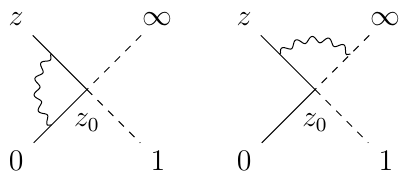
Figure 3 . Contributions to the four point blocks from the networks of open Wilson lines at the 1 =c order. The solid line represents an open Wilson line connecting z and 0 via z 0 and the dotted line represent an open Wilson line connecting 1 and 1 via z 0 . We should be careful when there is an exchange of spin 3 = 2 (cid:12)eld, and the situation depends on whether the exchange is between the solid and/or dotted lines.